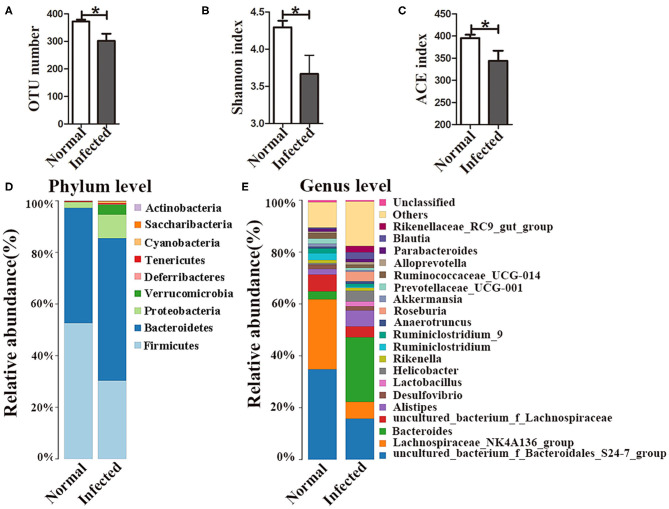
Changes in the gut microbiota in S. japonicum infected mice. (A) OTU numbers. (B) Shannon index values. (C) ACE index values. The stacked bar chart indicates the species distributions at the phylum level (D) and the genus level (E). * = p < 0.05.